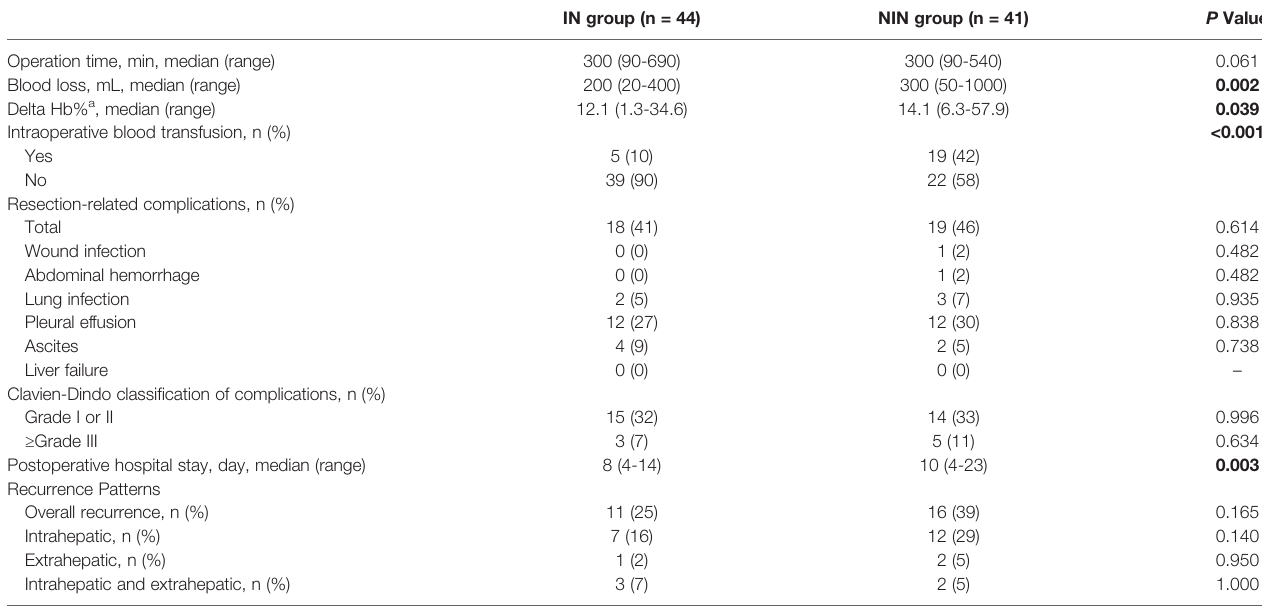
TABLE 2 | Perioperative Outcomes and Recurrence